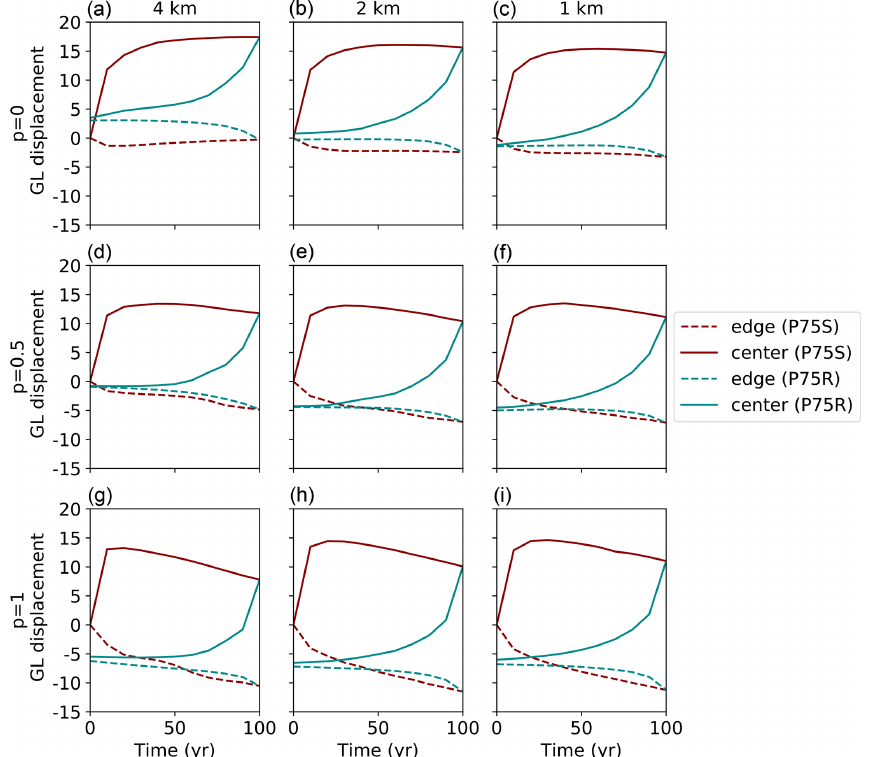
Figure 7. Grounding line displacement relative to the end of the MISMIP3d experiment Stnd for the first 100 years of experiments P75S (red) and P75R (cyan), at the center (solid line) and edge (dashed line) of the domain, and at resolutions of 4km (a, d, g) , 2km (b, e, h) , and 1km (c, f, i) for p = 0 (a, b, c) , p = 0 . 5 (d, e, f) , and p = 1 (g, h, i) . The DIVA stress approximation with a GLP was used for these